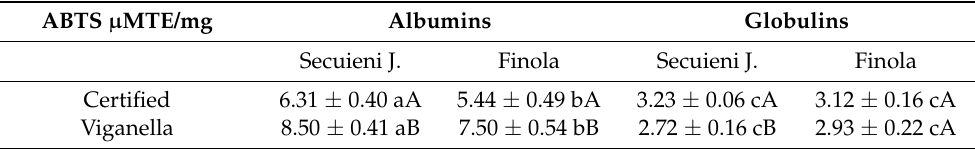
Table 2. Antioxidant properties of albumin and globulin hempseed extracts determined by ABTS assay and expressed as µ MTE/mg sample.